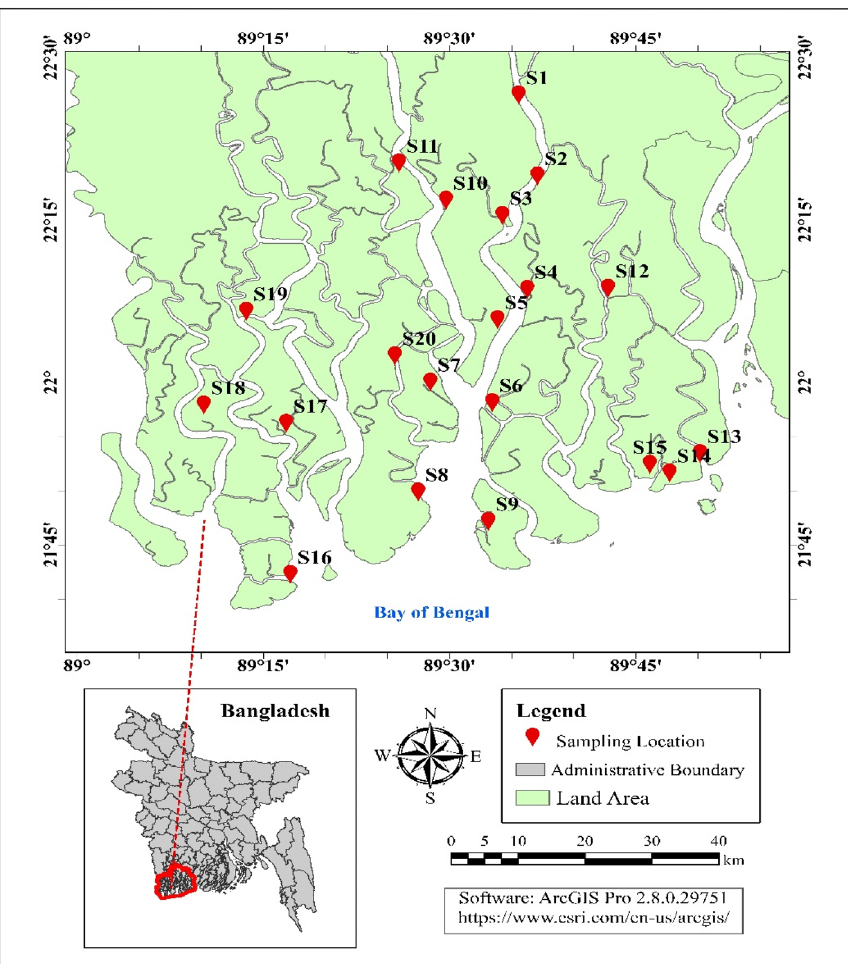
Figure 1. Study area map of the Sundarbans mangrove